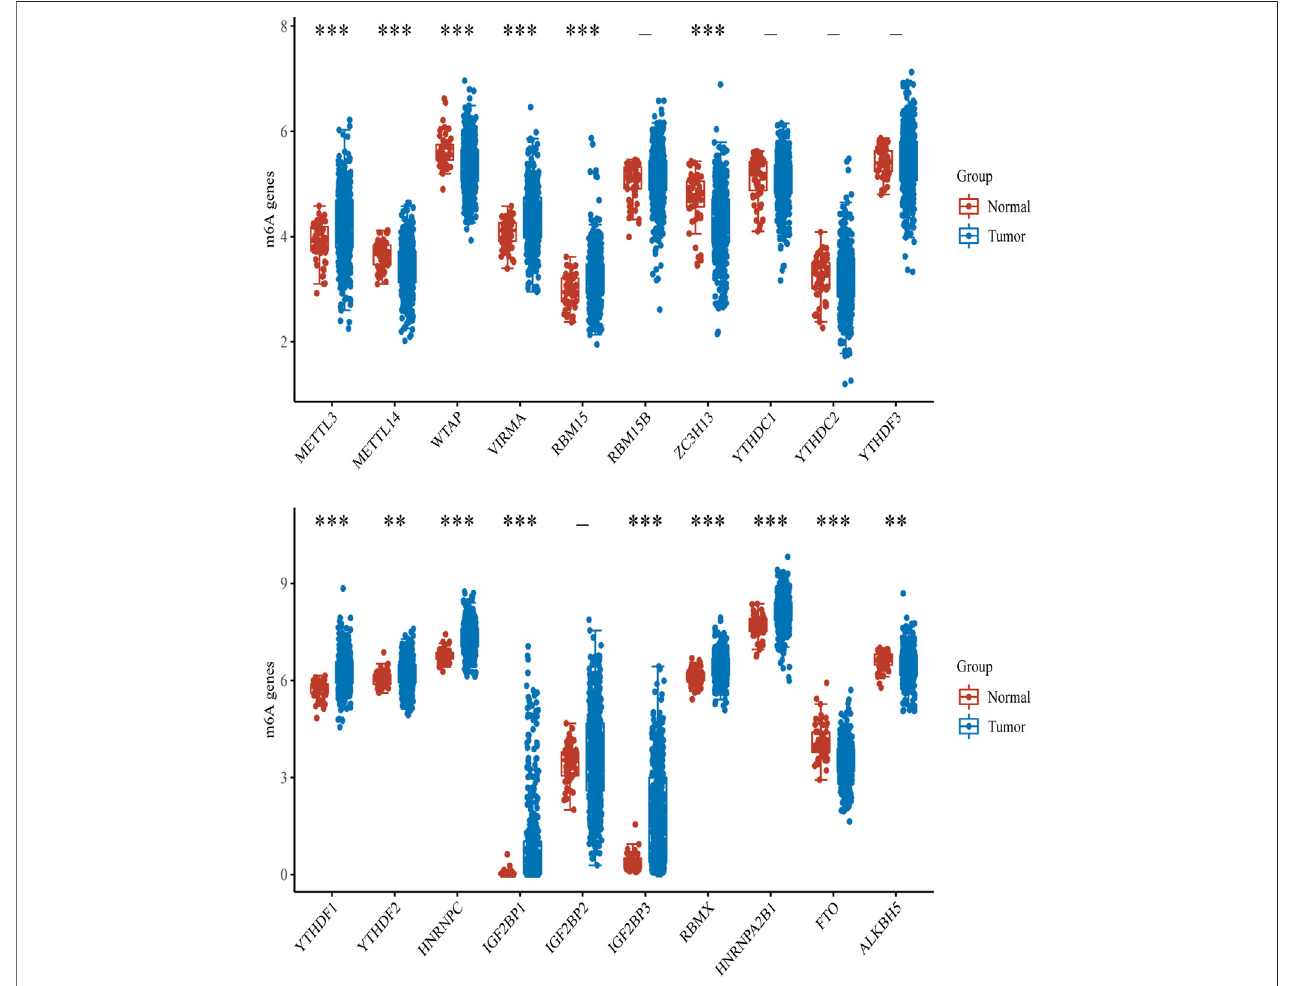
FIGURE 2 | Box diagram of expressions of m 6 A modi fi cation regulators between LUAD and normal samples. Red means normal tissue, and blue means tumor tissue. *** p < 0.001, ** p < 0.01, * p < 0.05.